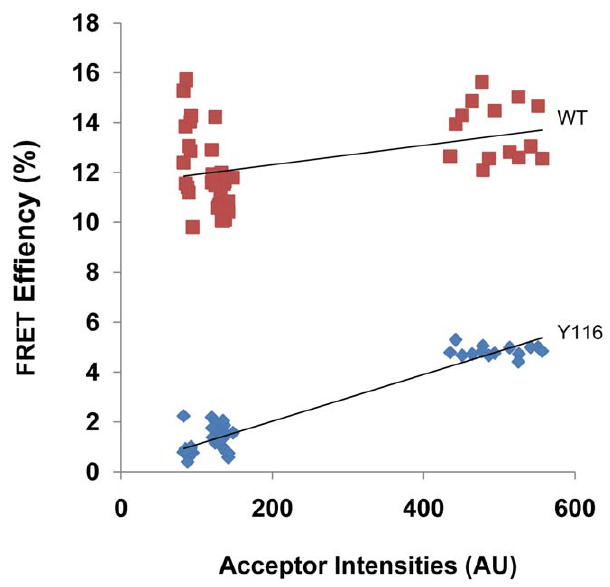
Figure 6. Effect of Y116 mutation on receptor. FRET efficiency of Y116 and full length TSHR are indicated at low and high acceptor values. Y116 shows decreased FRET efficiency compared to the WT type